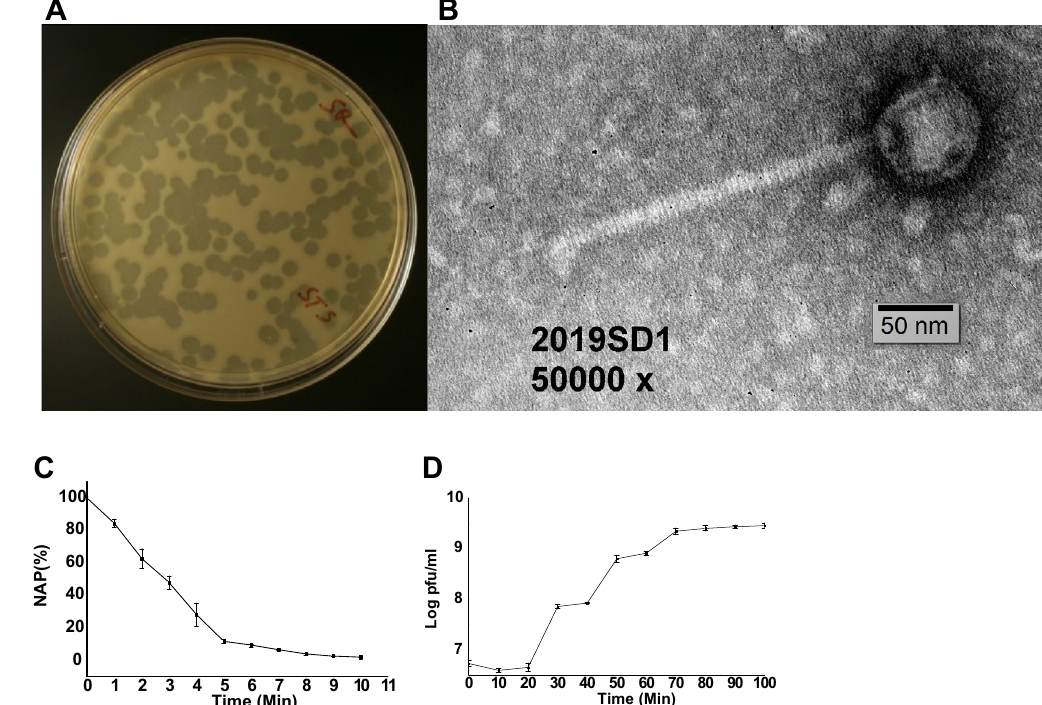
Figure 1. Plaque, TEM morphology, rate of adsorption and one-step growth curve of Shigella virus 2019SD1. ( A ) Plaques produced against S. dysenteriae type 1 using double agar plating assay, ( B ) Transmission electron micrograph ( C ) The rate of adsorption of phage to the S. dysenteriae type 1 host. Phages were added to the bacterial suspension at an MOI: 0.1. The percentage of non-adsorbed phages (NAP) was calculated at the indicated time points. The presented data are means of three independent experiments with error bars showing the standard error of mean (SEM). ( D ) One-step growth curve analysis. Plaque forming units (PFU) were recorded at different time interval post infection against host bacterium S. dysenteriae type 1. Bars represent